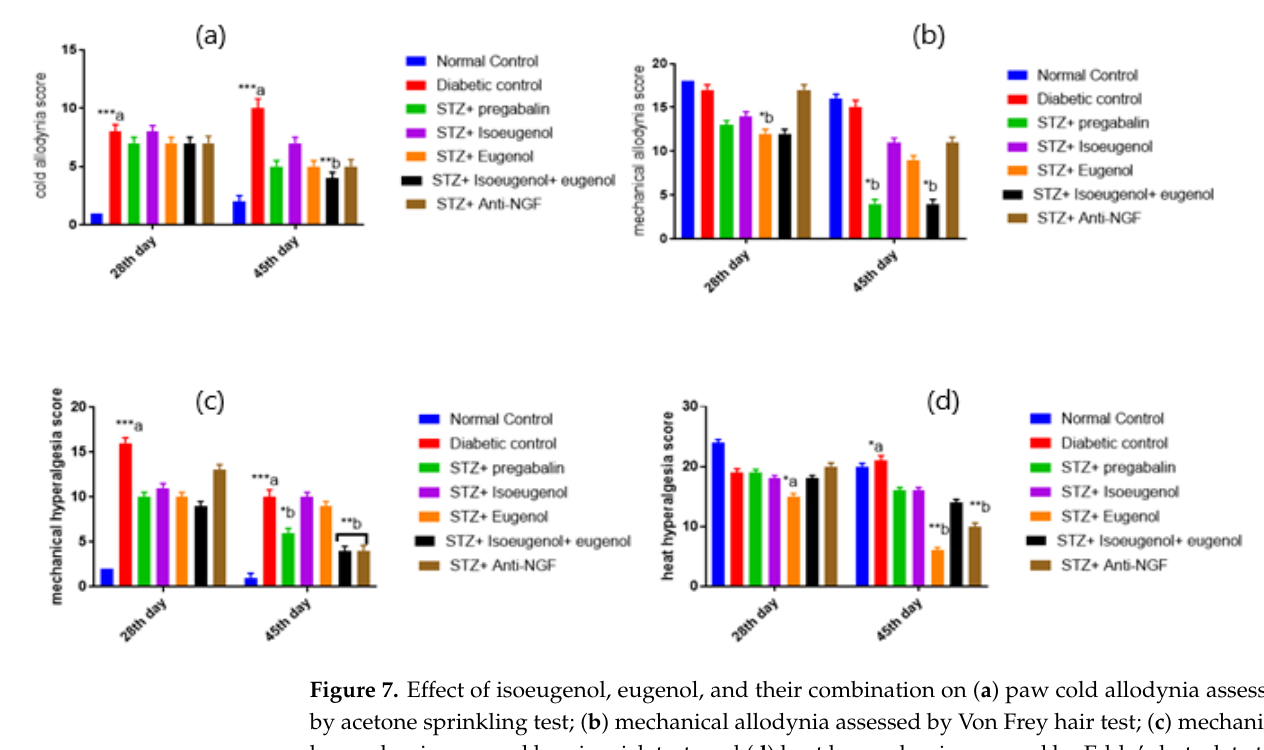
Figure 7. Effect of isoeugenol, eugenol, and their combination on ( a ) paw cold allodynia assessed by acetone sprinkling test; ( b ) mechanical allodynia assessed by Von Frey hair test; ( c ) mechanical hyperalgesia assessed by pinprick test; and ( d ) heat hyperalgesia assessed by Eddy’s hot-plate test. A p < value of 0.05 was considered statistically significant. Significance is represented as * p < 0.05, ** p < 0.01, and *** p < 0.001; a—normal control versus diabetic control corresponding to the same day, b—diabetic control versus treatment groups corresponding to the same day.